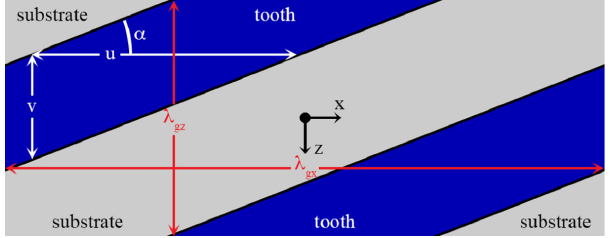
FIG. 5. Tilted grating with periodic boundary conditions in x and z direction and tan α ¼ λ